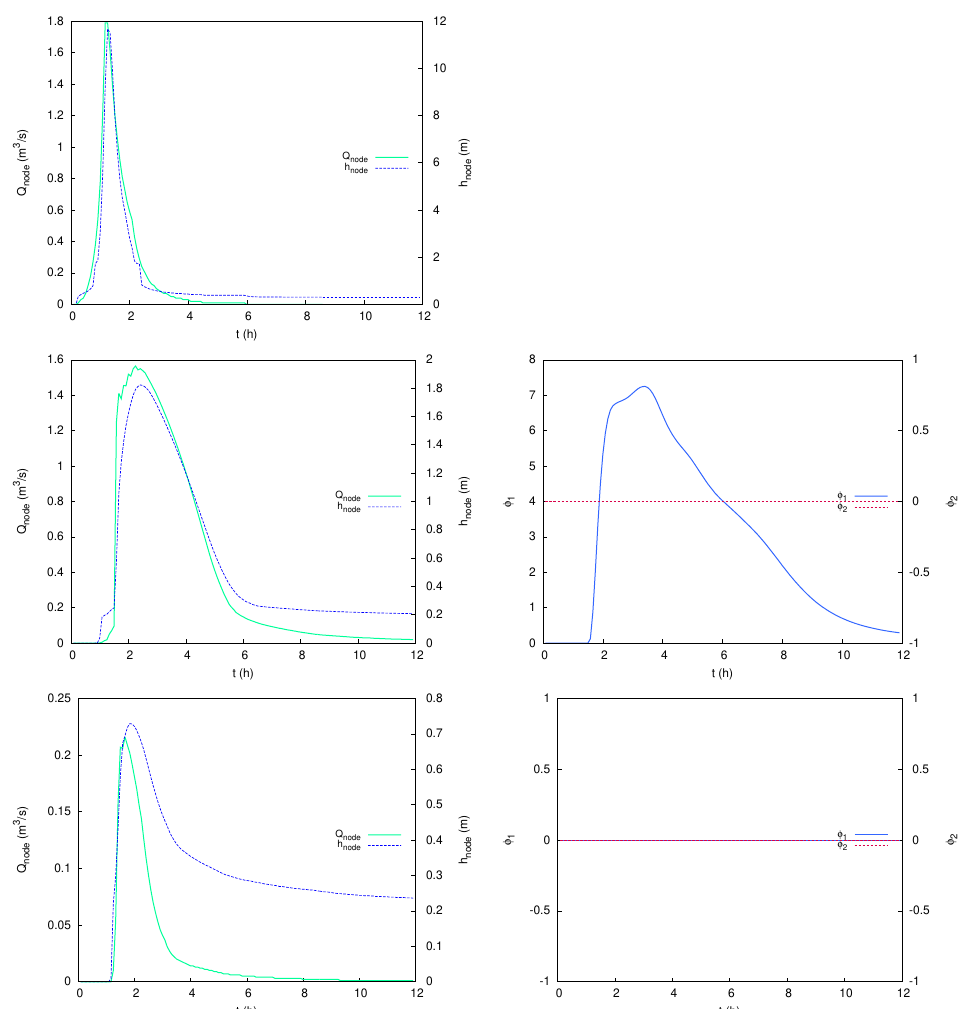
Figure 23. Case 3: Temporal evolution of sewer water depth and pollutant concentrations at nodes N8 ( upper ), JEI7 ( center ) and N3 ( lower ). Table 2. Summary of the computational times for Case 3. In this particular case, speed-up is calculated as a factor of the 6-cores CPU time.